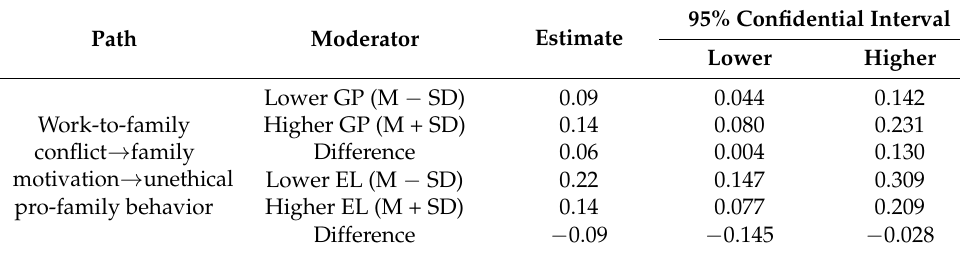
Table 4. Bootstrapping Moderated Mediation Effect Test